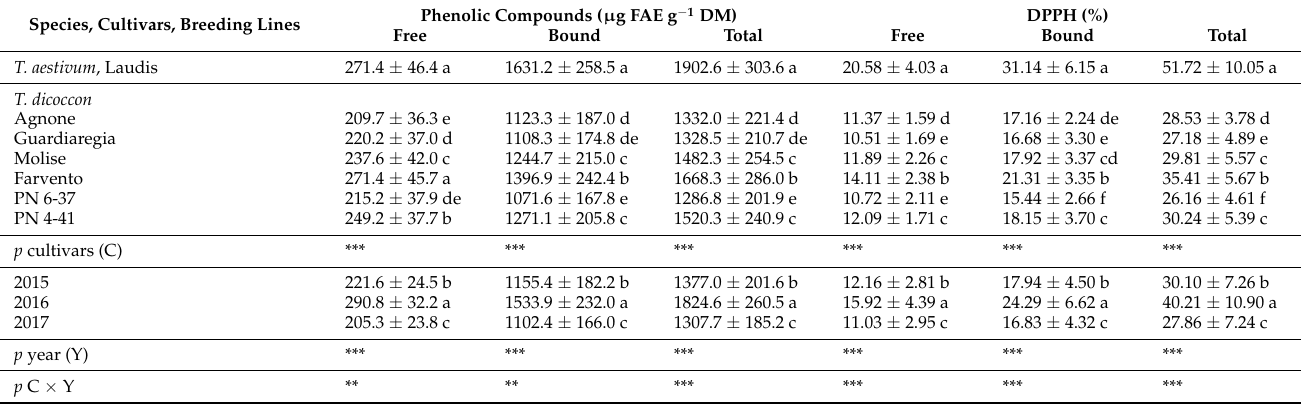
Table 2. Effect of wheat cultivars and growing years on phenolic concentrations ( µ g FAE g − 1 DM) and DPPH (%) in whole-grain